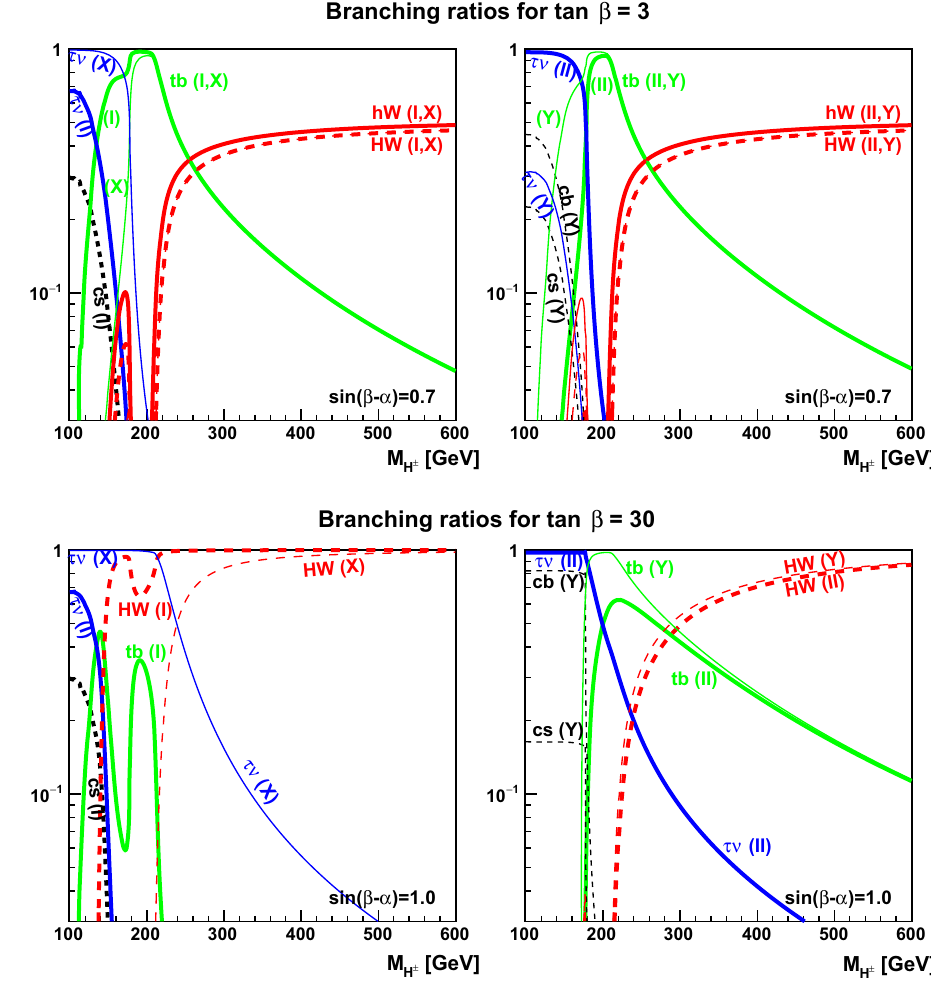
Fig. 4 Charged-Higgs branching ratios vs. M H ± , for tan β = 3 and 30, with two light neutral Higgs bosons h and H (125 and 130 GeV). Left Models I and X, right Models II and Y. Top sin (β − α) = 0 . 7, bottom sin (β − α) = 1